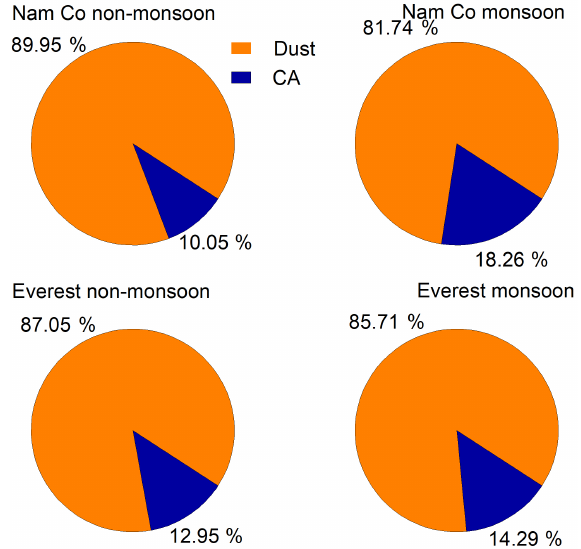
Figure 3. Percentage of MD and CA relative to their sum during both non-monsoon and monsoon periods at the Nam Co and Everest